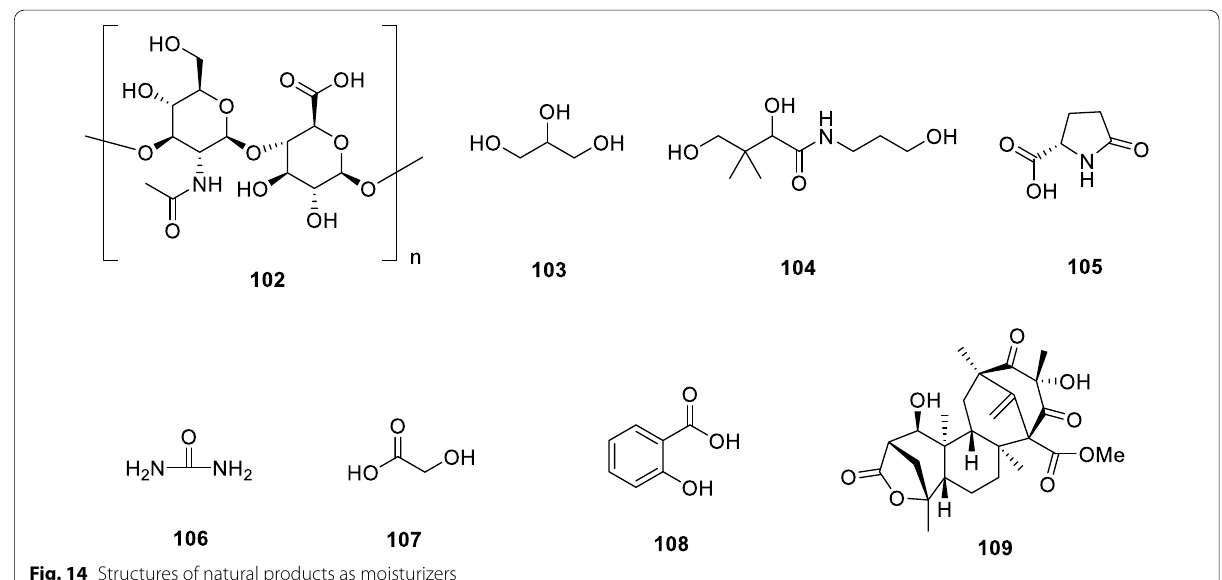
Fig. 14 Structures of natural products as